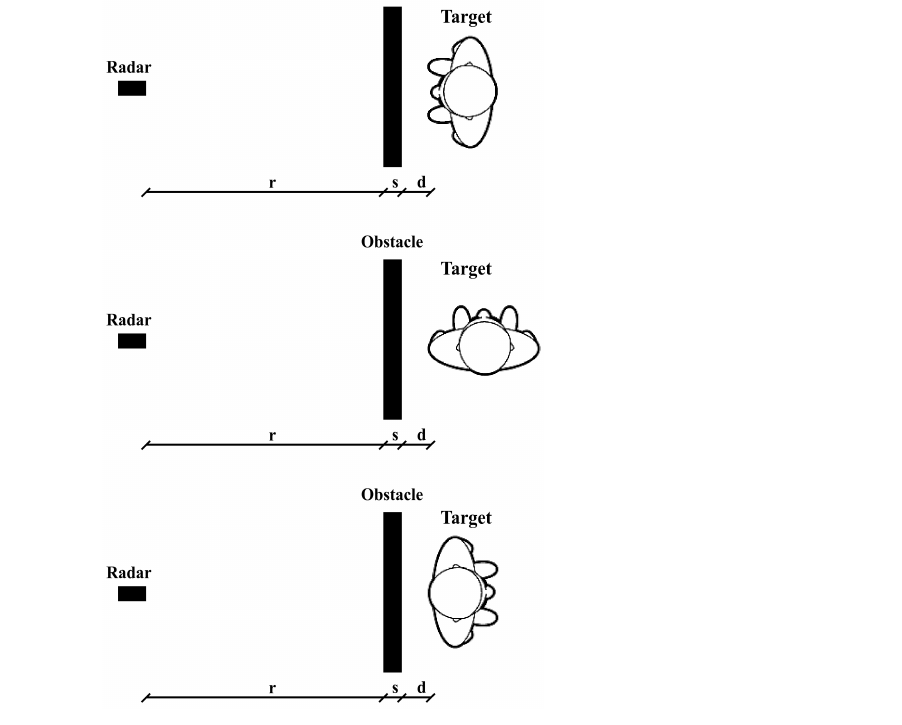
Figure 2. The different body orientations considered within our experiments for through-wall human